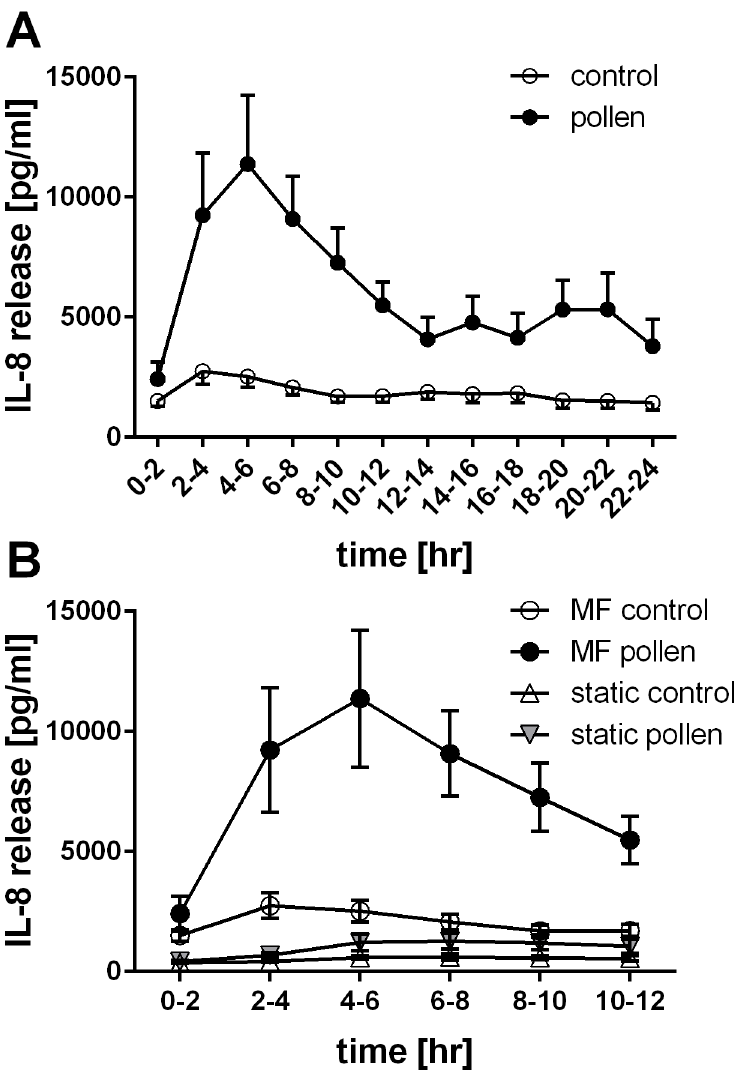
Fig 6. Time-dependent release of IL – 8 by differentiated PBECs induced by pollen. a: Using the microfluidic culture system, basolateral flow was collected for 2h periods over 24h. Release of IL – 8 was analysed by ELISA. n = 15 independent experiments using 13 different donors. b: Comparison of pollen induced IL – 8 release in static and microfluidic culture conditions in 2h intervals over a 12h period. In static culture conditions, aliquots of basolateral medium were taken at matching time points. Release of IL – 8 was analysed by ELISA. Microfluidic culture (MF) n = 15; static n = 5 independent experiments using 13 and 4 different donors